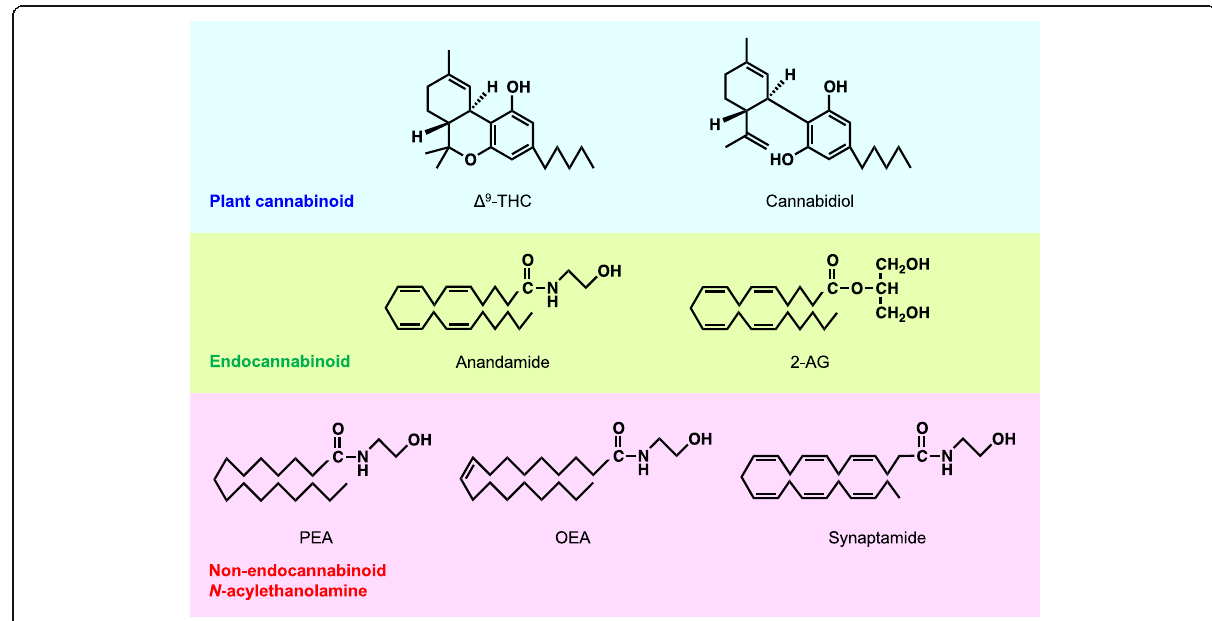
Fig. 1 Chemical structures of representative plant cannabinoids, endocannabinoids, and non-endocannabinoid N